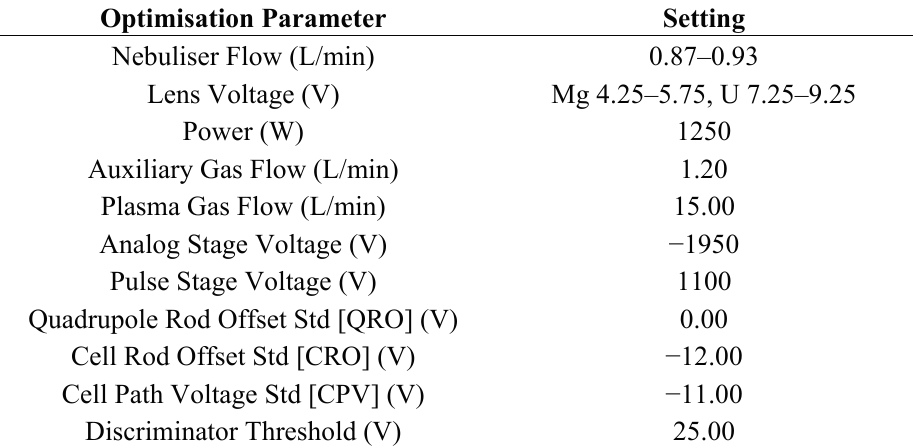
Table 1. PerkinElmer Elan DRC II typical optimisation